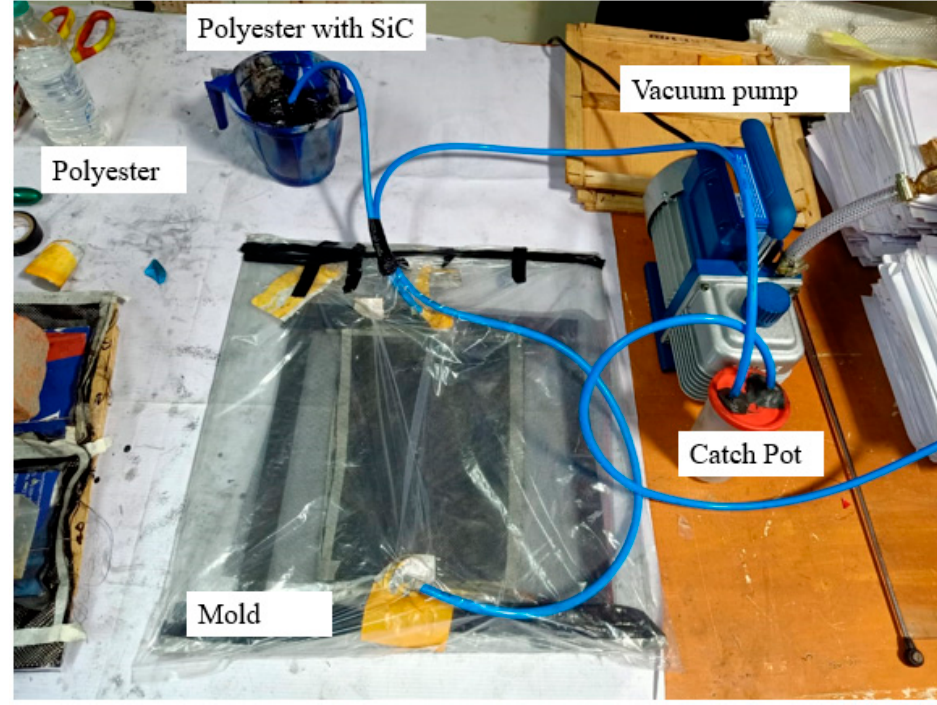
Figure 3. Preparation of composite materials using the vacuum bag infusion technique.